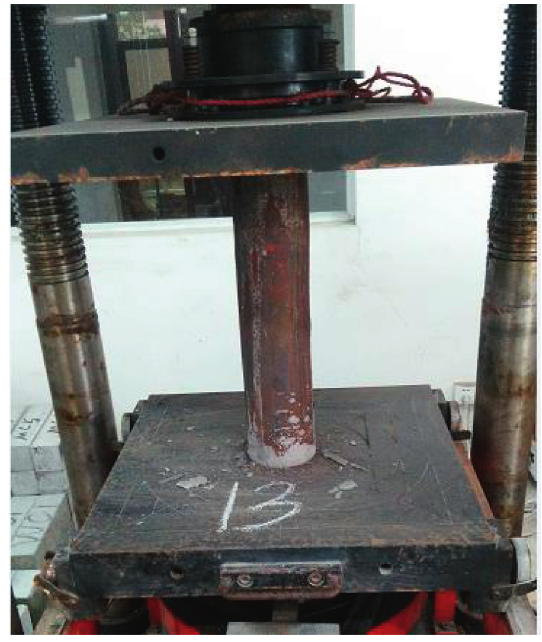
Figure 2: Test setup.